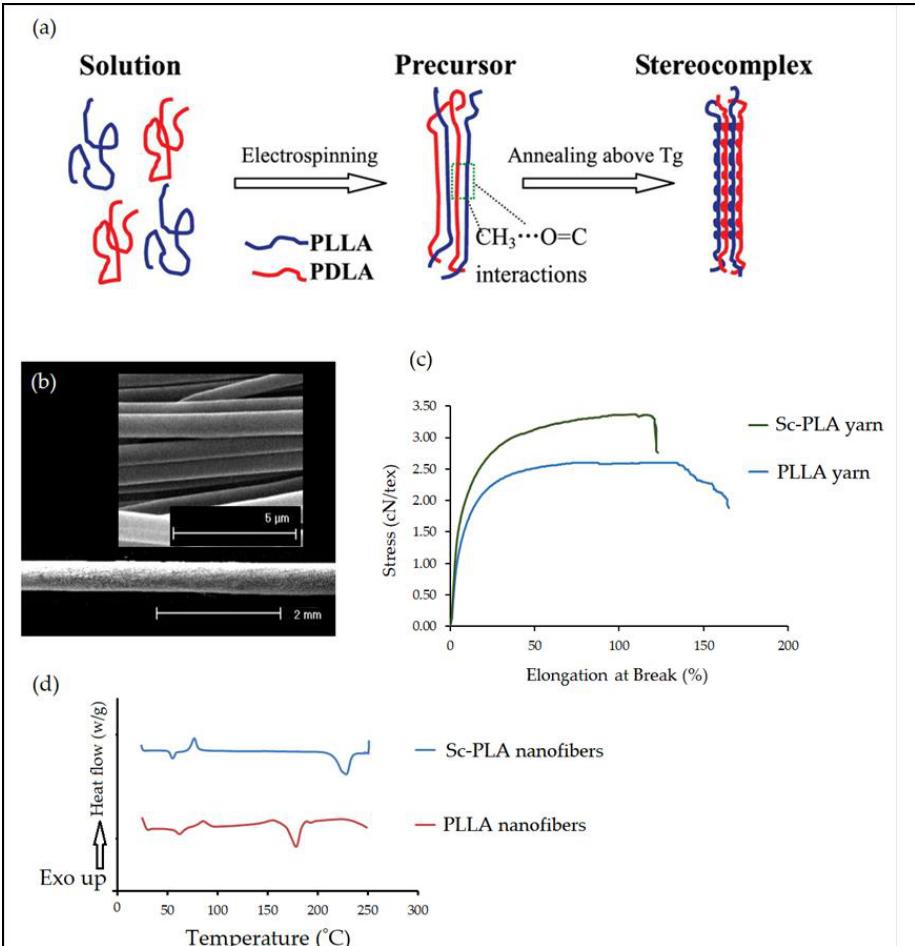
Figure 10. ( a ) Intermolecular ordering for stereocomplex formation in the electrospun PLA fibers Reproduced with permission from [67] (License number: 5237071296979), ( b ) SEM micrographs of electrospun Sc-PLA structures, unpublished original picture by the authors, ( c ) Stress–Elongation curves of PLA-based electrospun yarns, unpublished original picture by the authors ( d ) DSC curves of electrospun PLLA and Sc-PLA fibers, unpublished original picture by the authors.